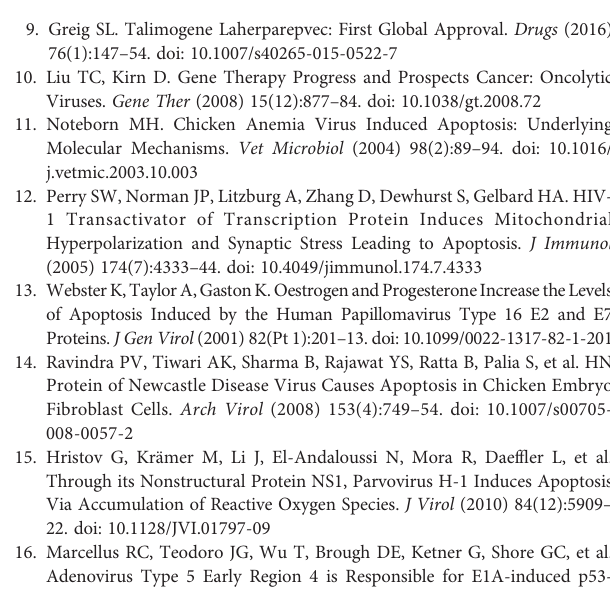
Supplementary Figure 1 | Multiple Sequence alignment of the NS1 protein of CPV, H-1 PV, and MVM. The protein sequences are less similar at the terminal but the structure is almost conserved in the middle portion of polypeptides (helicase